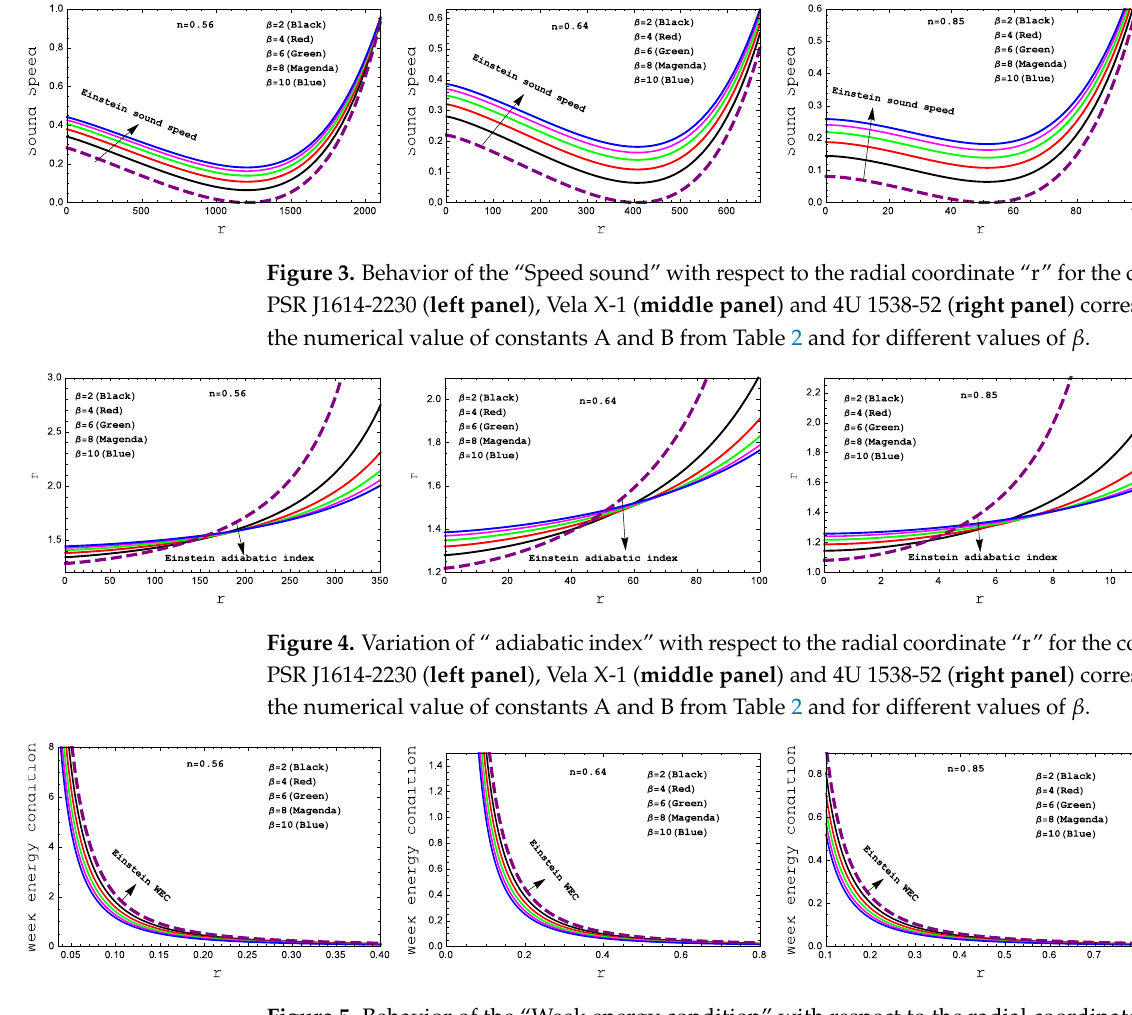
Figure 5. Behavior of the “Week energy condition” with respect to the radial coordinate “r” for the compact stars PSR J1614-2230 ( left panel ), Vela X-1 ( middle panel ) and 4U 1538-52 ( right panel ) corresponding to the numerical value of constants A and B from Table 2 and for different values of β